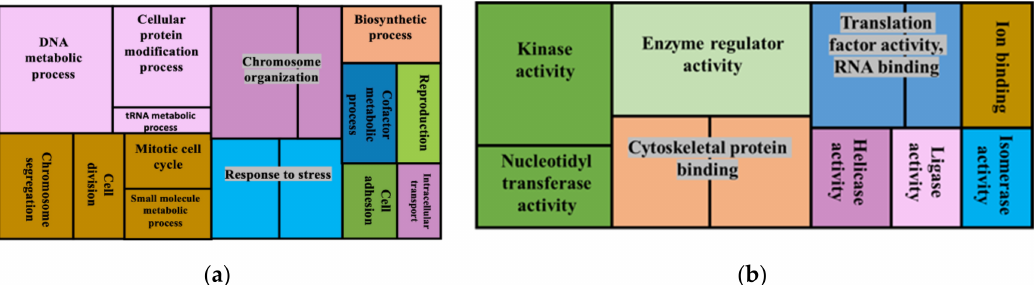
Figure 2. GO enrichment analysis for genes associated with deletions showing overrepresented GO terms, biological processes ( a ) and molecular functions ( b ). The whole genome annotations of the reference FSP34 were used as the reference set and genes associated with deletions were used as the test set.